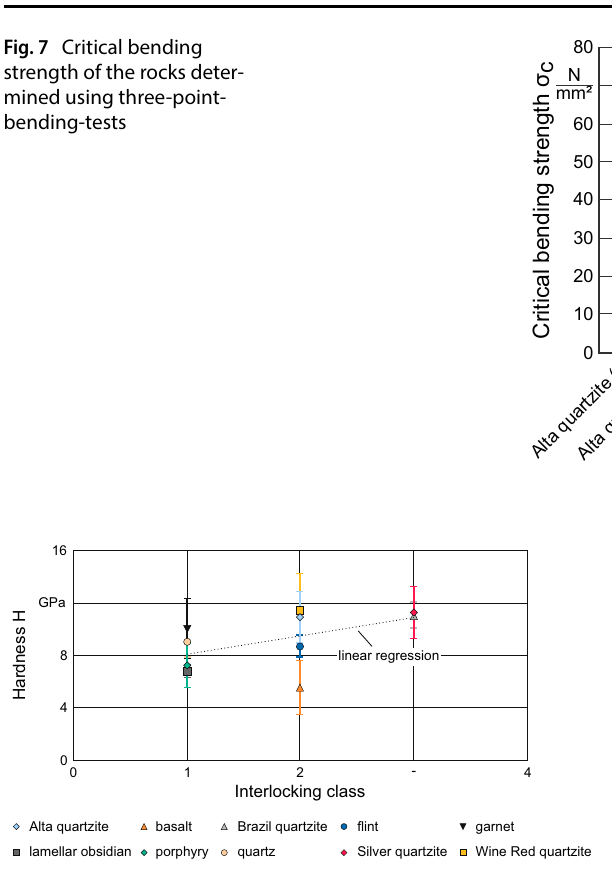
Fig. 8 Influence of interlocking class on Vickers hardness of the